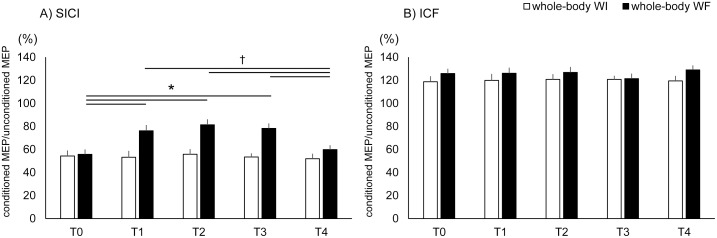
Changes in short-interval intracortical inhibition (SICI) and intracortical facilitation (ICF) for each intervention.The values for short interval intracortical inhibition and intracortical facilitation were normalized for each subject to their corresponding values in single-pulse stimulation. White and black bars show whole-body WI and WF, respectively. Asterisks (*) indicate significant differences (p<0.05) compared with T0. Daggers (†) indicate significant differences (p<0.05) compared with T4.